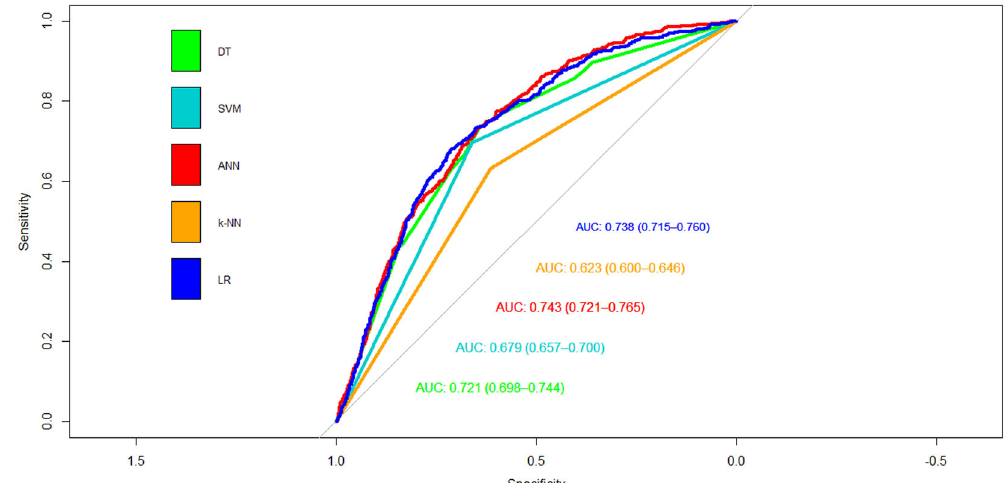
Fig. 6 AUC of ML methods for the 90-day readmission. Five supervised machine learning algorithms: Decision Tree (DT), Support Vector Machine (SVM), Arti fi cial Neural Network (ANN), k-Nearest Neighbor (k-NN), and Logistic Regression (LR) are applied to build prediction models.